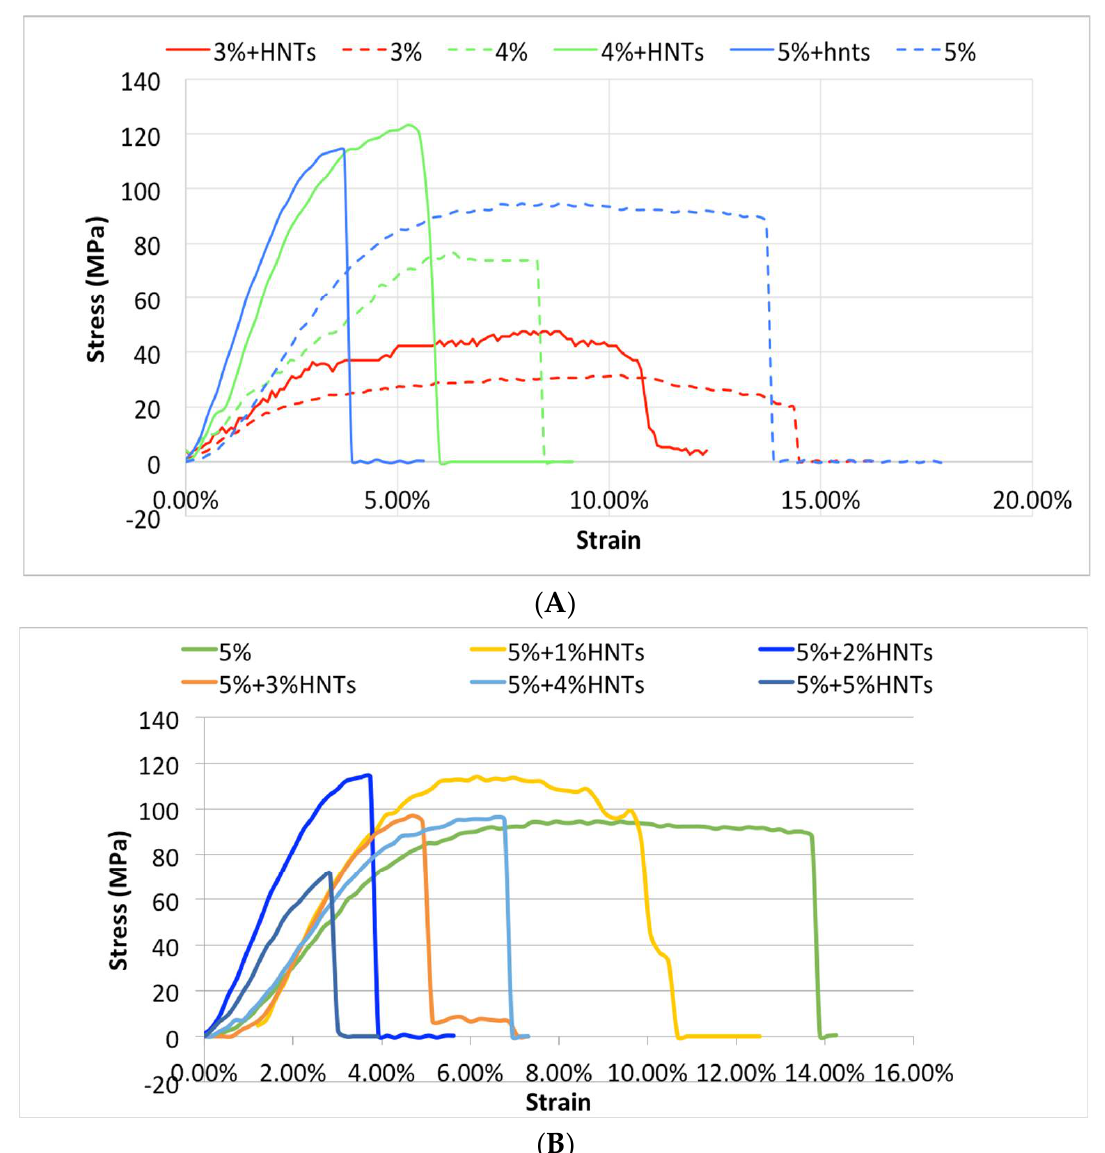
Figure 3. The stress-strain profile of CS and CS/HNTs. ( A ) Tensile test of pure chitosan (CS) with the HNT additive groups (CS/HNTs). In this graph, every CS/HNT compound has a higher stress value compare to CS group. (3% CS/2% HNTs > 3% CS, 4% CS/2% HNTs > 4% CS, 5% CS/2% HNTs > 5% CS). Simultaneously, a higher concentration of chitosan showed higher stress values (5% > 4% > 3%), however, the strain values displayed a different response (5% < 4% < 3%). ( B ) 5% CS/1% HNTs showed a major improvement in elongation, while 5% CS/2% HNTs showed the greatest improvement in strength. Increasing of number of HNTs gradually decreased its reinforcement ability, until at these concentrations (CS/HNTs (5% CS/ 5% HNTs), the nanocomposites was weaker and more fragile than pure CS. The step-wise failure behavior (slippage) at the end of each profile represents the fracture point of each specimen.